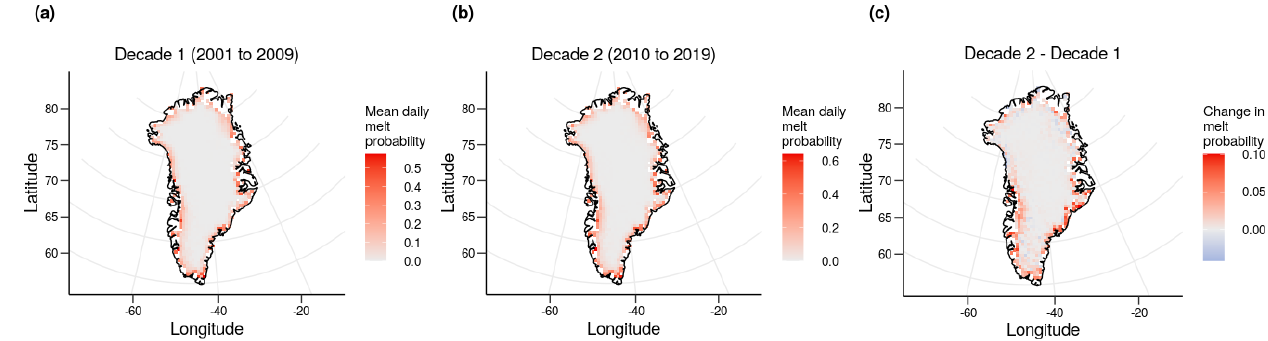
Figure 9. The average probability of a melt temperature on any given summer (May–September inclusive) day from 2001 to 2009 (a) and 2010 to 2019 (b) and the change in melt probability between 2001 to 2009 and 2010 to 2019 calculated from the fitted mixture